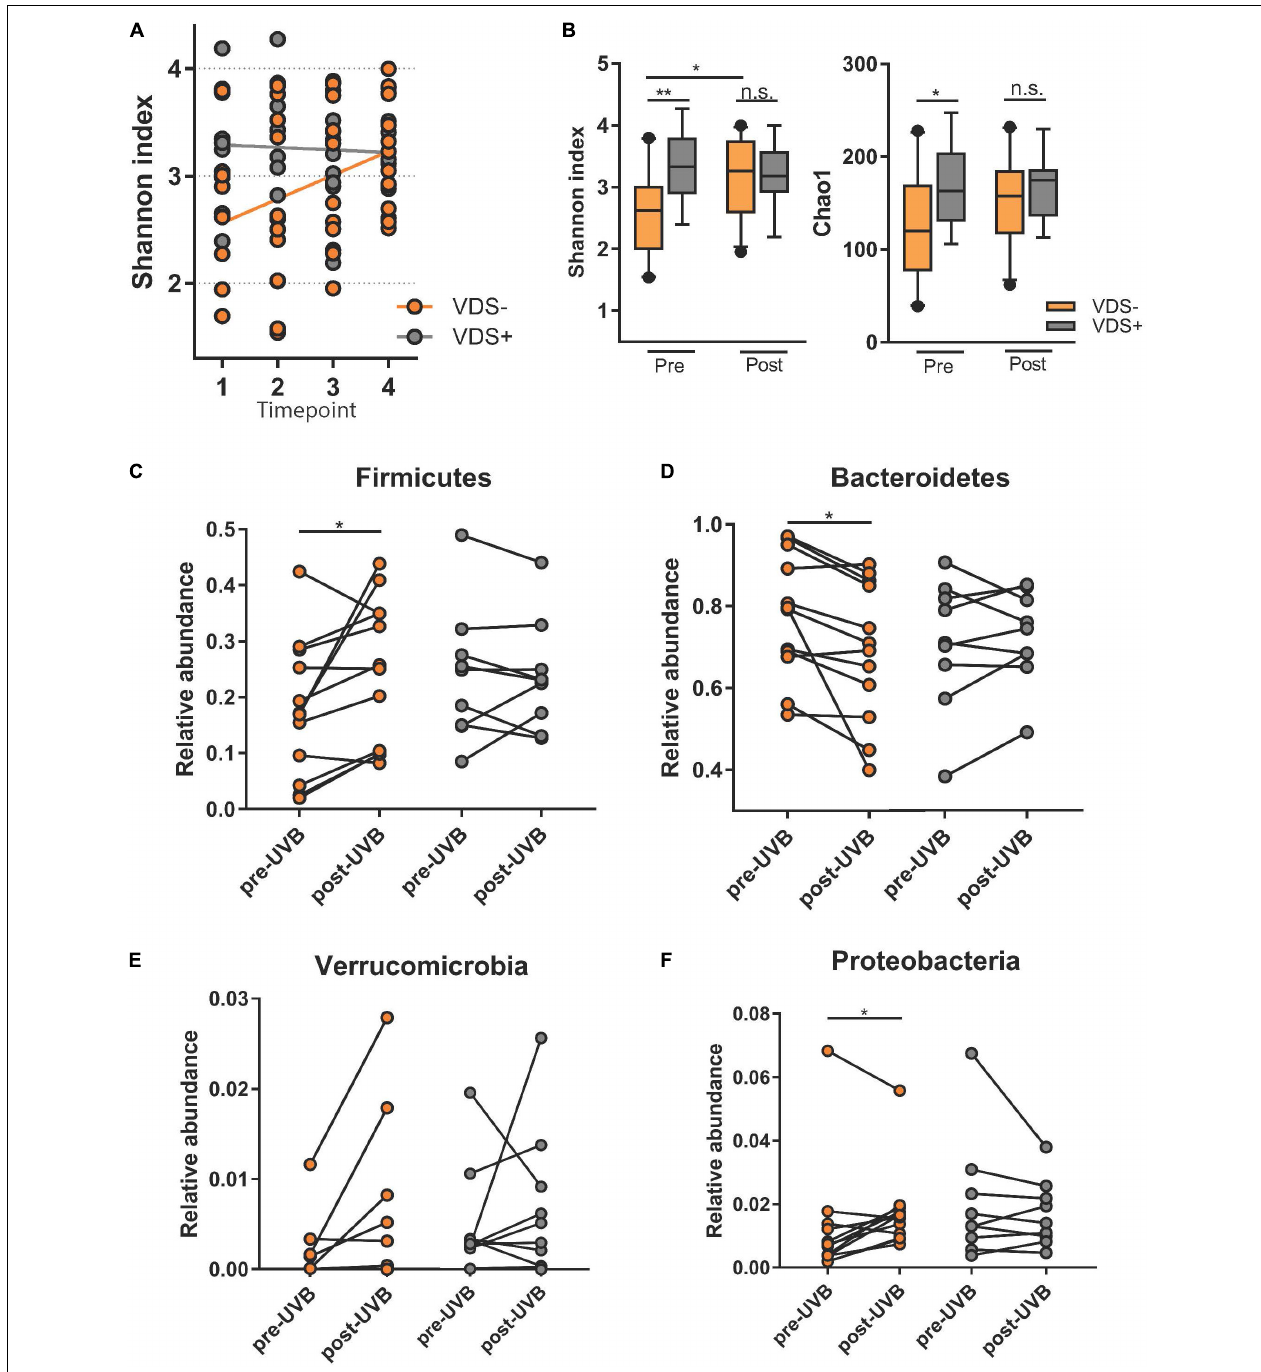
FIGURE 2 | Microbiome analysis comparing study cohort before and after UVB exposures. Time points 1 and 2 are pre-UVB exposure and timepoints 3 and 4 are after UVB exposures. (A) Linear mixed model of the Shannon index of the different timepoints shows a significant effect of time for the UVB light exposures in the VDS − group, but not the VDS + group ( p = 0.0001). (B) Alpha diversity measures diversity and richness before and after the UVB light exposures of the supplementation groups, and shows a significant difference before the UVB exposures, but not after the UVB exposures. An increase in diversity was observed only for the VDS − group (multiple comparison one-way ANOVA, p- adj 0.024). (C) Comparative analysis of taxa specific relative abundance of Firmicutes pre and post-UVB light exposure. Each dot represents the average relative abundance of the two microbiome samples per timepoint from each participant. A significant increase in Firmicutes was found for the VDS − group ( p = 0.0287), but no significant difference in the VDS + group. (D) A significant decrease of Bacteroidetes was found for the VDS − group ( p = 0.0164). (E) No significant differences of Verrucomicrobia was detectable pre and post UVB light exposures for both VDS groups . (F) A significant increase in the relative abundance of Proteobacteria was found for the VDS − group ( p = 0.0493), while no significant difference was found in the VDS + group. ∗ p < 0.05, ∗∗ p < 0.001.